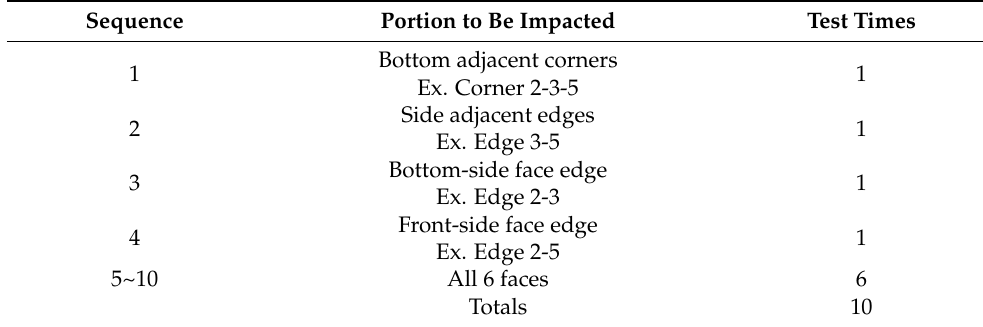
Table 3. Drop sequence and number of times